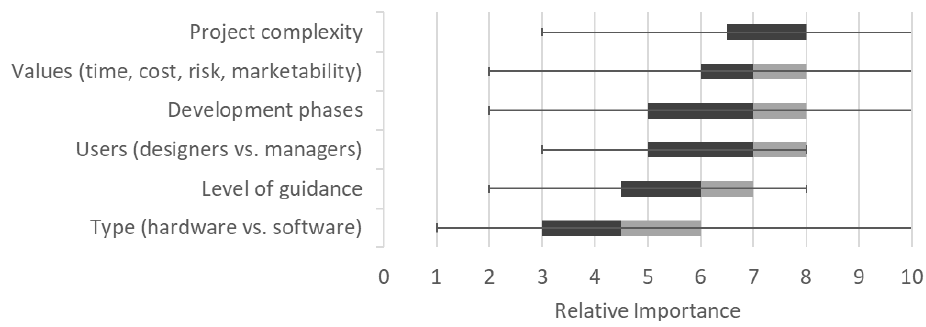
Figure 11. Perceived relative importance of criteria based on survey responses. Shaded boxes span the interquartile range, separated by the median. Error bars represent upper and lower extremes. Approaches are ordered by decreasing